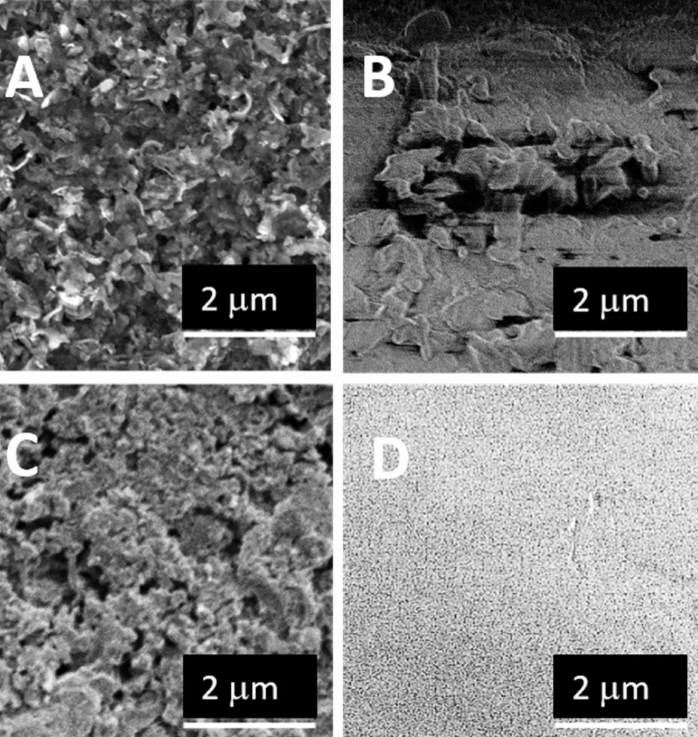
Figure 13. SEM images of anode surfaces ( A , C ) before and ( B , D ) after 100 cycles of discharging and charging. The anodes are made of ( A , B ) as-received silicon flakes and ( C , D ) silicon flakes coated with nanocarbons at 650 ◦